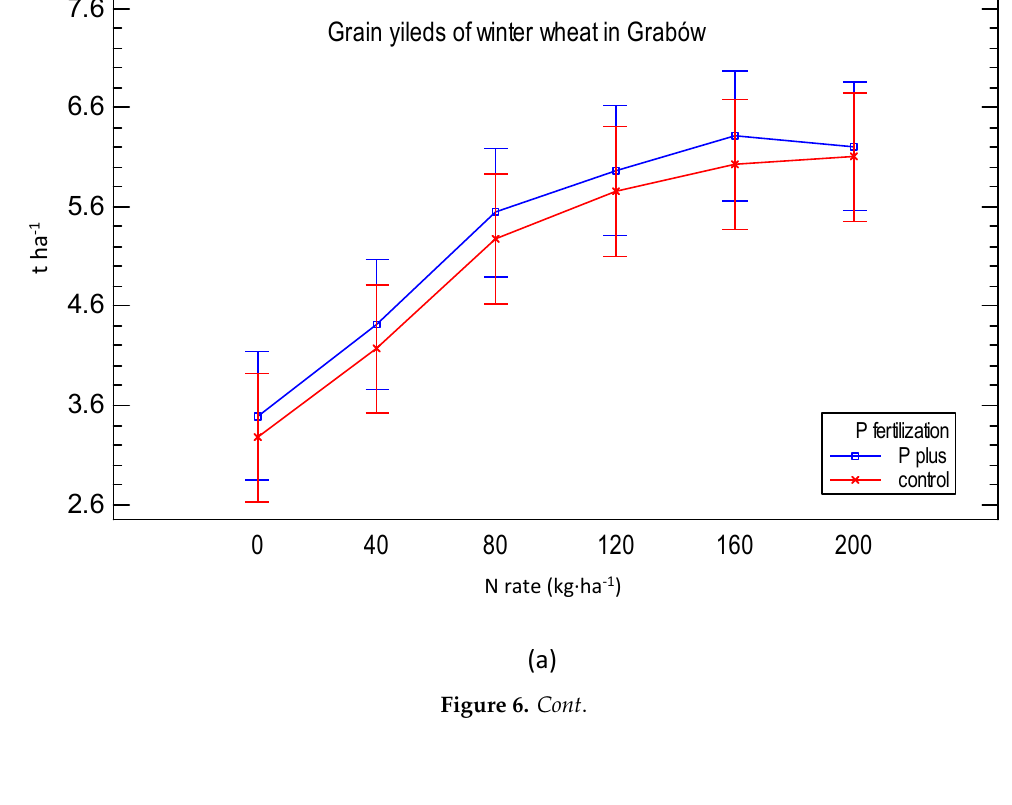
Figure 5. Grain yields of winter oilseed rape at increasing additions of Nitrogen (N) fertilizer at the P-plus and control levels of phosphorus (P); 95% Tukey HSD intervals; n = 336 for ( a ) Grabów (P fertilization HSD 0.405) and n = 288 for ( b ) Baborówko (P fertilization HSD 0.321).